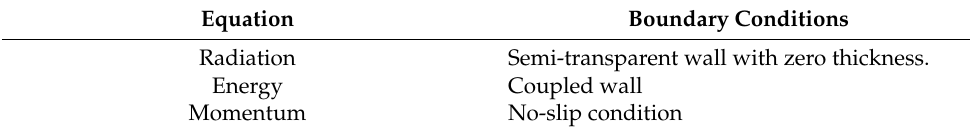
Table A5. Greenhouse cover faces.